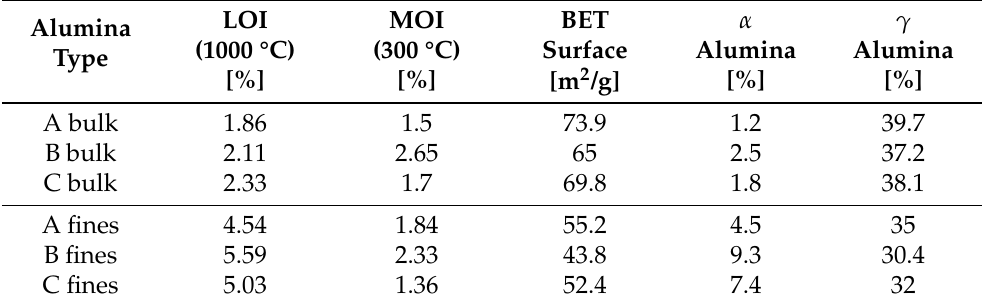
Figure 1. PSD of the different aluminas displayed to the left, and accumulative PSD to the right. Table 1. Selected alumina properties.